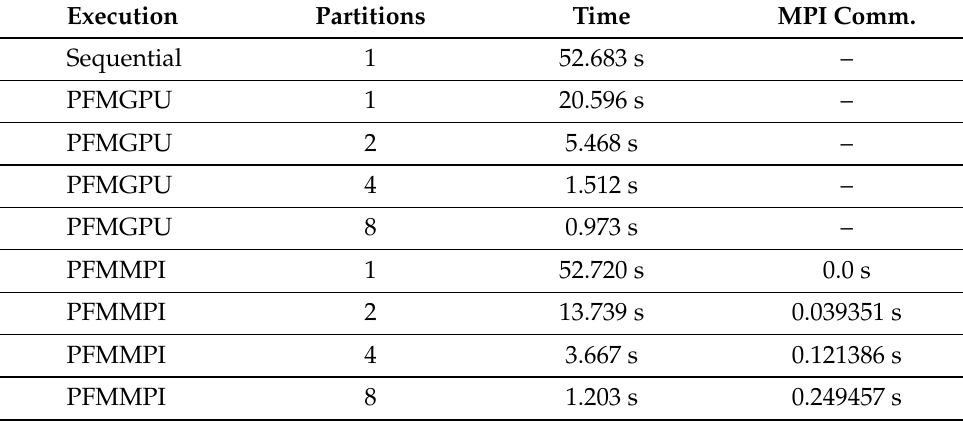
Table 3. Runtimes for the partial schools dataset.